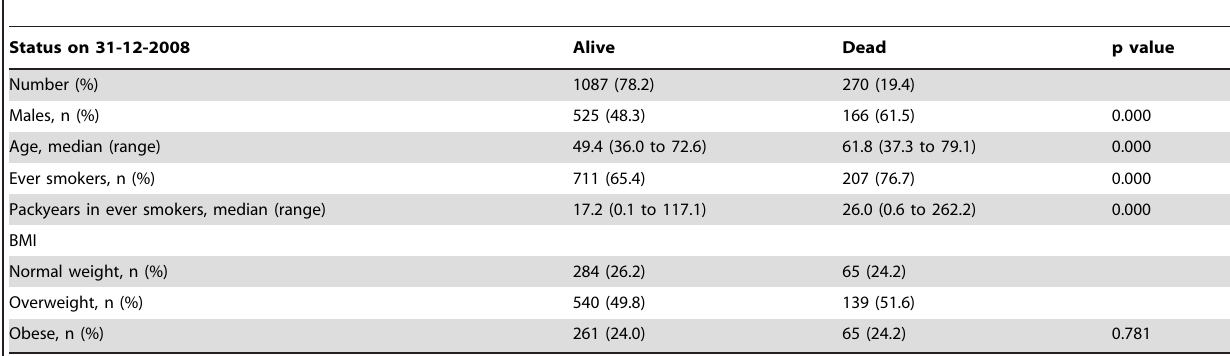
Table 1. Characteristics of participants at visit 1989/1990 by vital status on Dec 31 st , 2008.